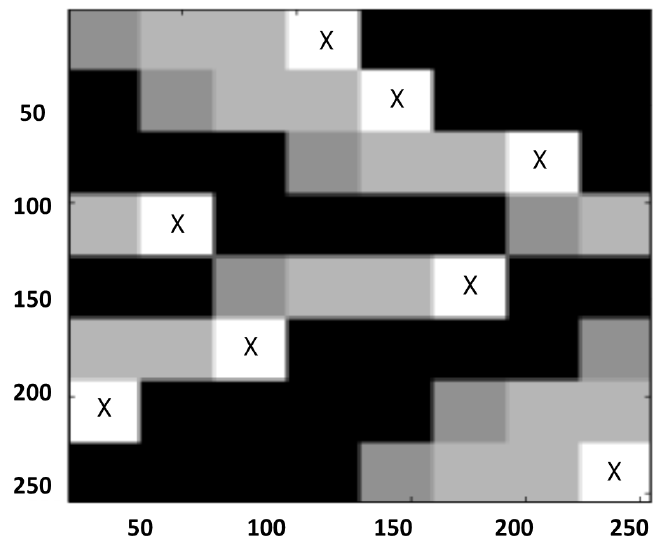
Figure 12. Red only